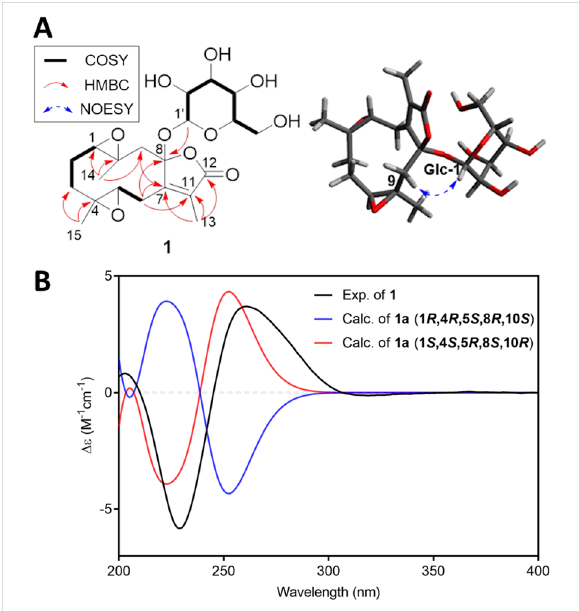
Figure 2: Structure elucidation of 1 . (A) Key COSY, HMBC, and NOE correlations of 1 . (B) Comparison of calculated ECD data of 1a and ex- perimental ECD spectrum of 1